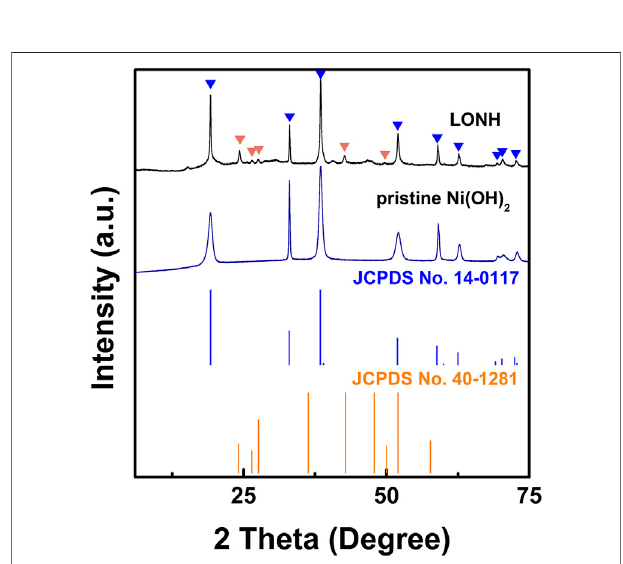
FIGURE 2 | XRD patterns of the as-prepared LONH, Ni(OH) 2 samples, as well as Ni(OH) 2 (JCPDS No. 14-0117) and La 2 O 3 (JCPDS No.40-1281). The peaks from Ni(OH) 2 and La 2 O 3 are signi fi ed by blue and orange triangles, respectively.